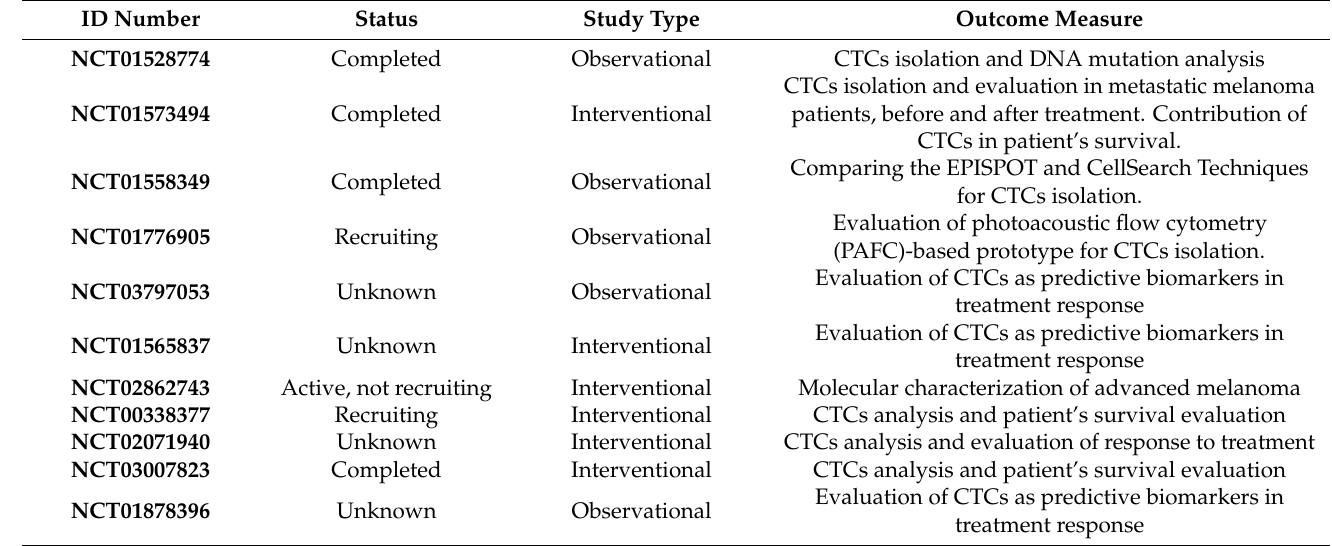
Table 1. CTCs involvement in melanoma clinical